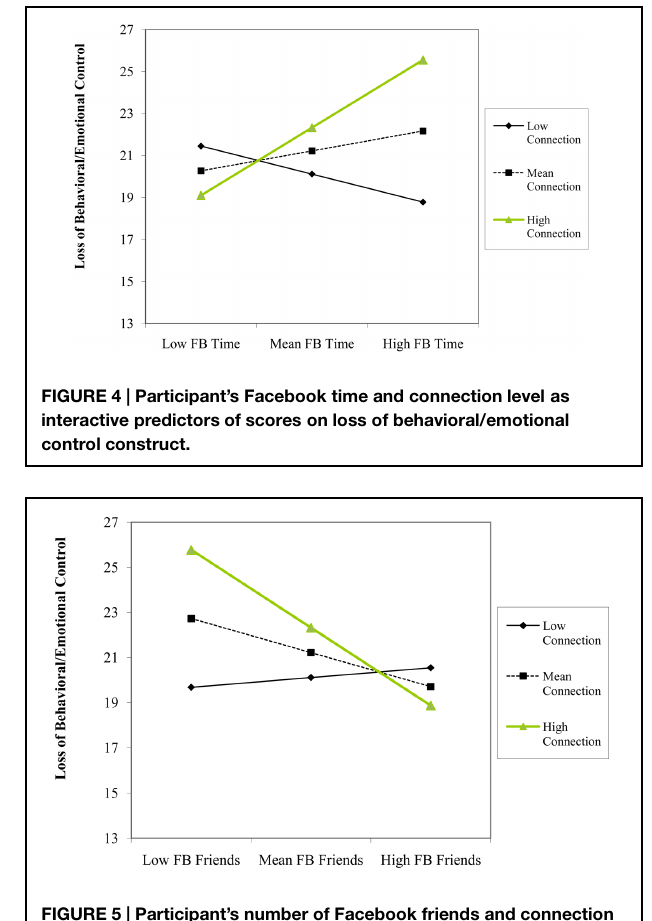
FIGURE 5 | Participant’s number of Facebook friends and connection level as interactive predictors of scores on loss of behavioral/emotional control